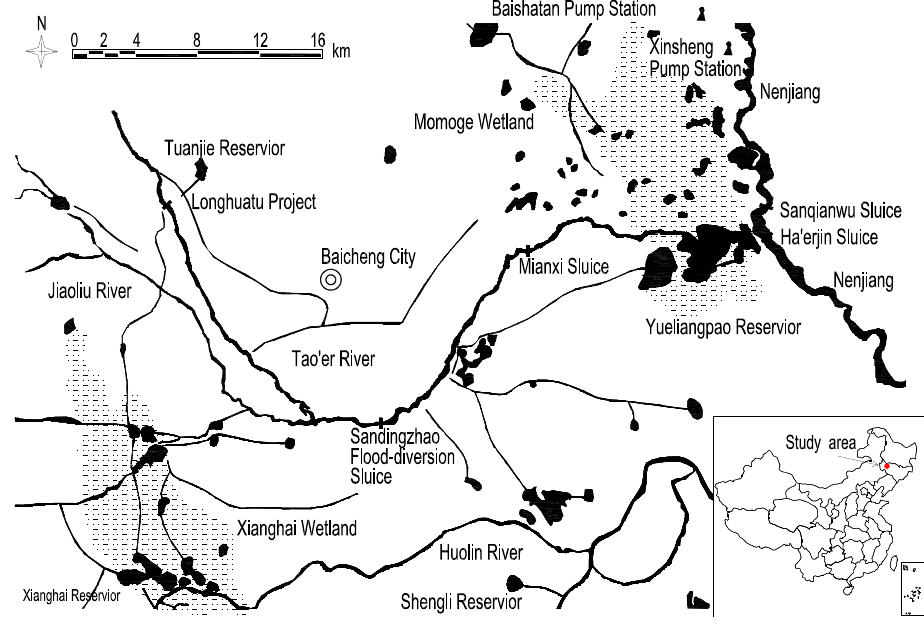
Fig. 1 Diversion works of wetlands and floodwater utilization Fig. 1. Diversion works of wetlands and floodwater